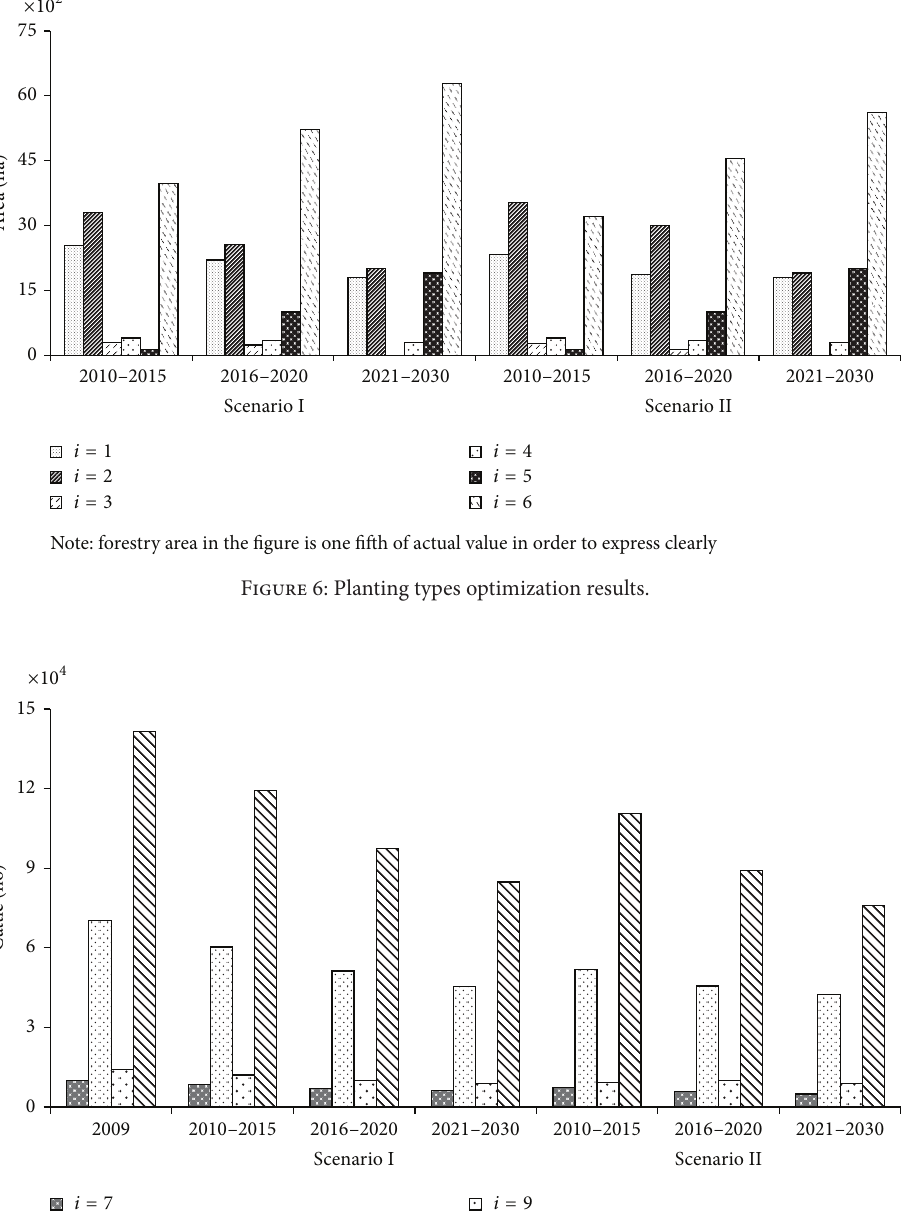
Figure 7: Livestock husbandry optimization